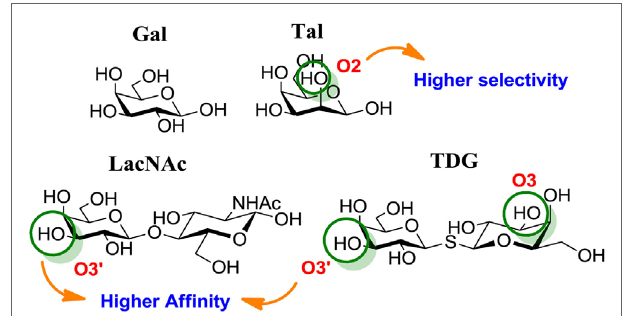
FiGURe 7 | Mono and disaccharides as building blocks to design galectin inhibitors . Structures of galactose (Gal), talose (Tal), N - acetyllactosamine (LacNAc), and thiodigalactoside (TDG). Green circles denote critical modified positions in search for high-binding affinity and selective galectin